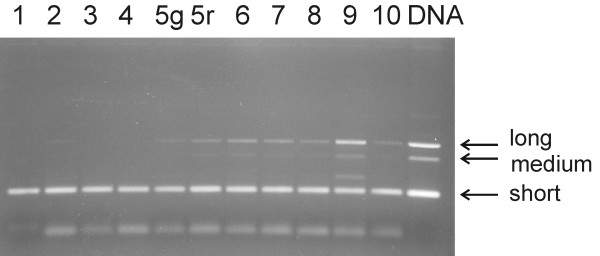
Expression of VvF3'5'H-2 during the progress of ripening. Length polymorphic transcripts of VvF3'5'H-2 were detected semi-quantitatively after cDNA samples had been normalised upon actin gene expression, at the sampling dates reported in Fig 9. The short, medium and long transcripts were named according to the fragment size amplified from genomic DNA. At sampling 5, green berries (5g) were kept separated from red berries (5r). PCR amplification on 'Merlot' genomic DNA was loaded in the right extreme lane.